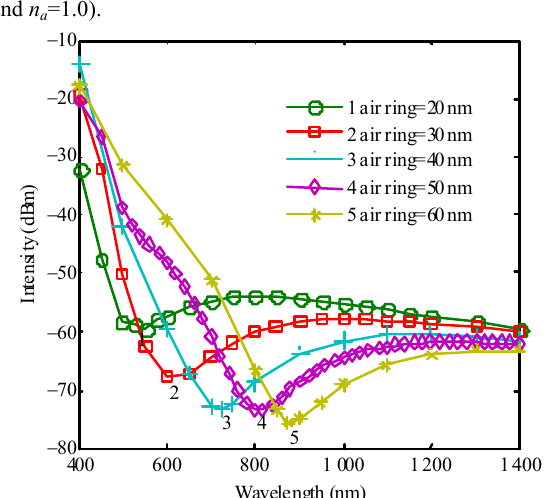
Fig. 4 SPR spectra with different thicknesses of air ring (residual cladding=50 nm, Au film=50 nm, and n a =1.0).